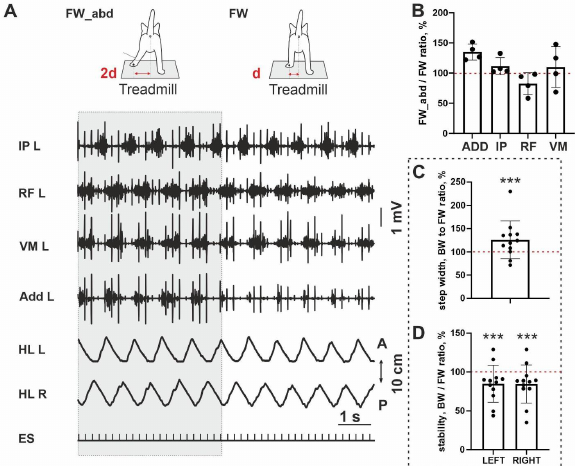
Figure 3. Abduction test and step characteristics during FW and BW stepping. ( A ) Representa- tive example of the EMG activity during normal FW stepping (FW) and stepping with abduction (FW_abd). ( B ) The ratio in the muscle activity during FW and FW_abd conditions. OX axis, muscles. ( C ) A percent ratio of the step width between FW and BW stepping. ( D ) A percent ratio of the stability index between FW and BW stepping. Left, right—left and right hindlimb. *** p <